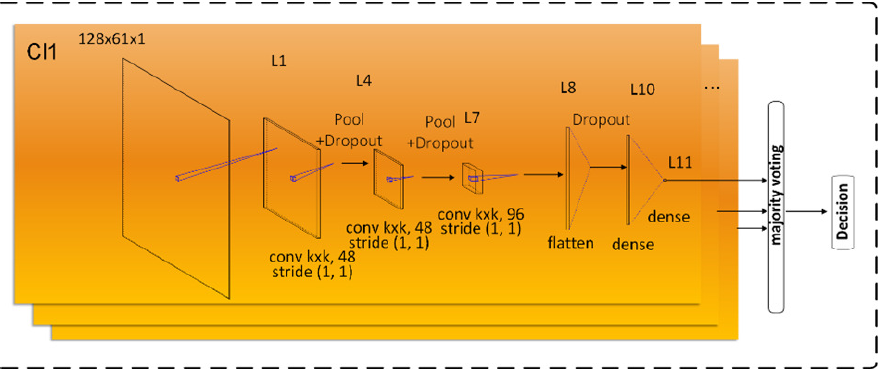
Figure 12. Final classifier consisting of 10 CNNs and majority voting.